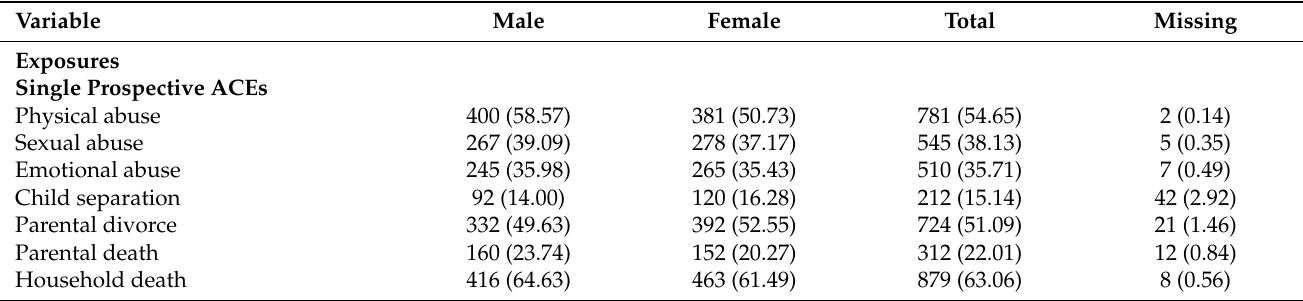
Table 1. Description of the study sample ( n =